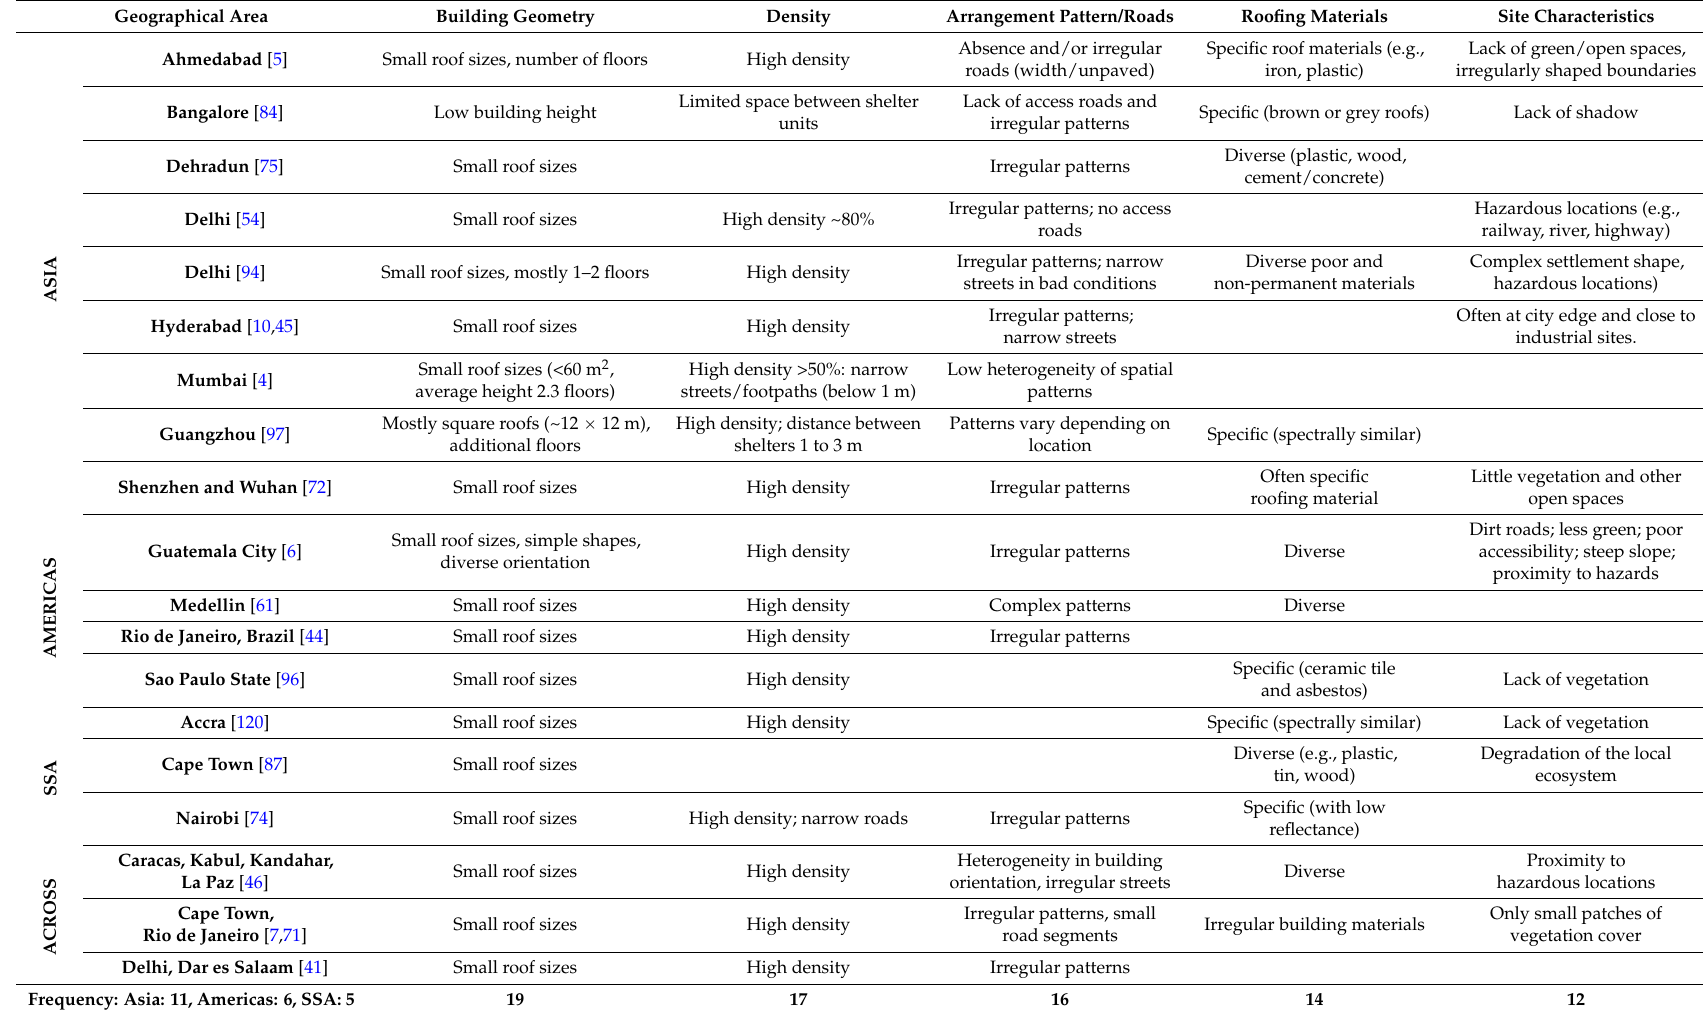
Table 4. Physical characteristics of slums in selected journal